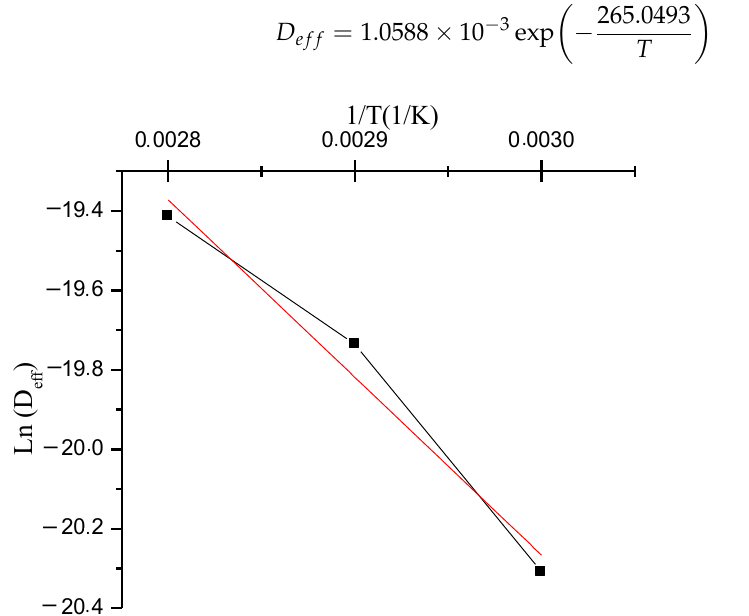
Figure 8. Relationship between effective moisture diffusivity and reciprocal absolute temperature. 3.5.1. Total Energy Utilization of The Forced Convection Solar Dryer The total energy used by the convective solar dryer to dry the Arbutus unedo L. fruit samples at different temperatures is presented in Figure 9.